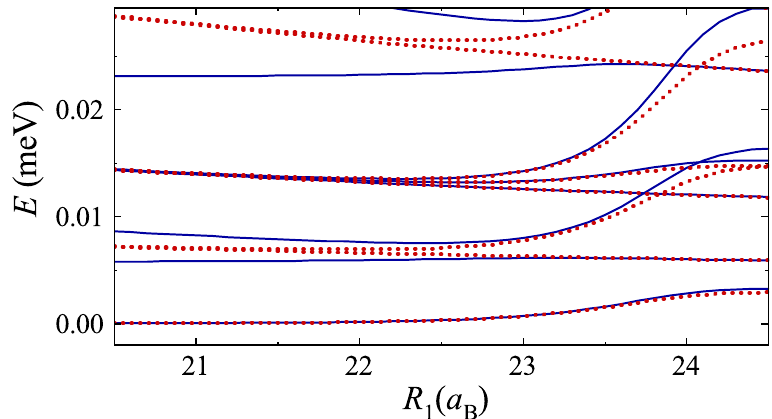
Figure 5. Comparison of exact (blue solid lines) and Kronig–Penney (red dots) calculation of two exciton energy spectrum. The radius of external ring is fixed as R 2 = 25 a B . In the limit of distant rings, the mixing between relative and center of mass motion becomes essential, violating the validity of approximate